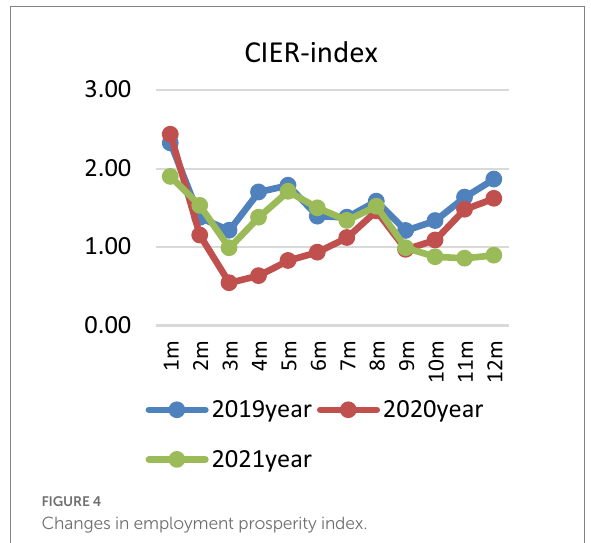
FIGURE 4 Changes in employment prosperity